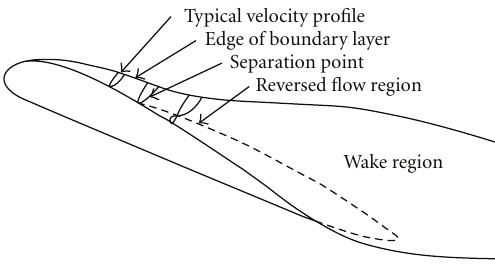
Figure 1: Steady separation on an airfoil [17].